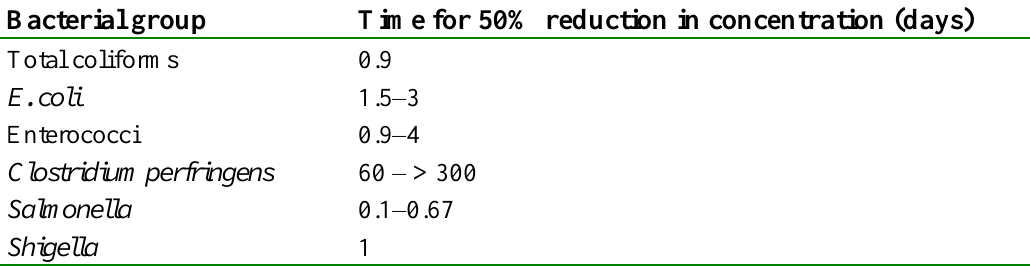
Table 9. Reduction times for fecal bacteria in surface waters a